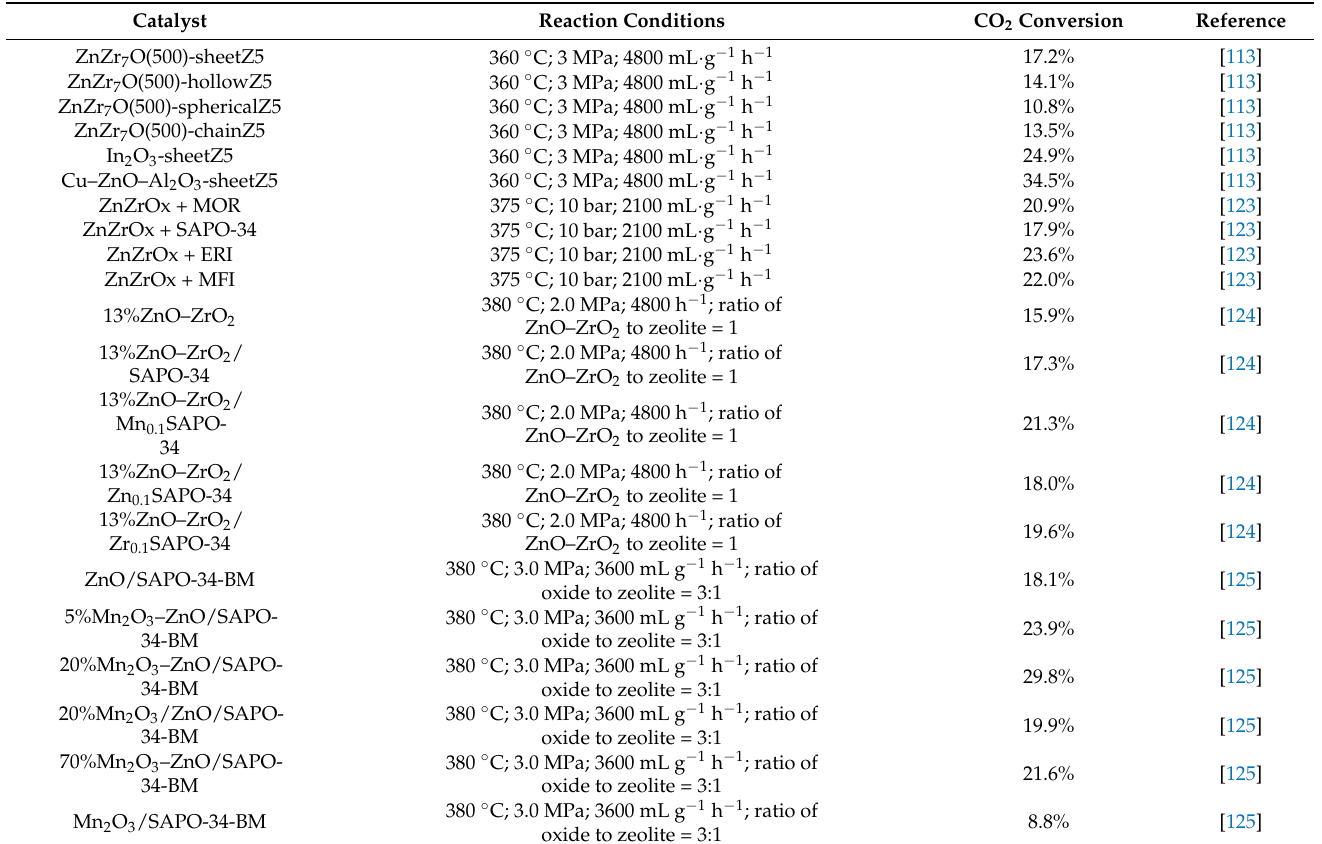
Table 5. Innovative tandem catalysts developed for CO 2 hydrogenation through methanol pathway, tested at CO 2 /H 2 feed ratio of